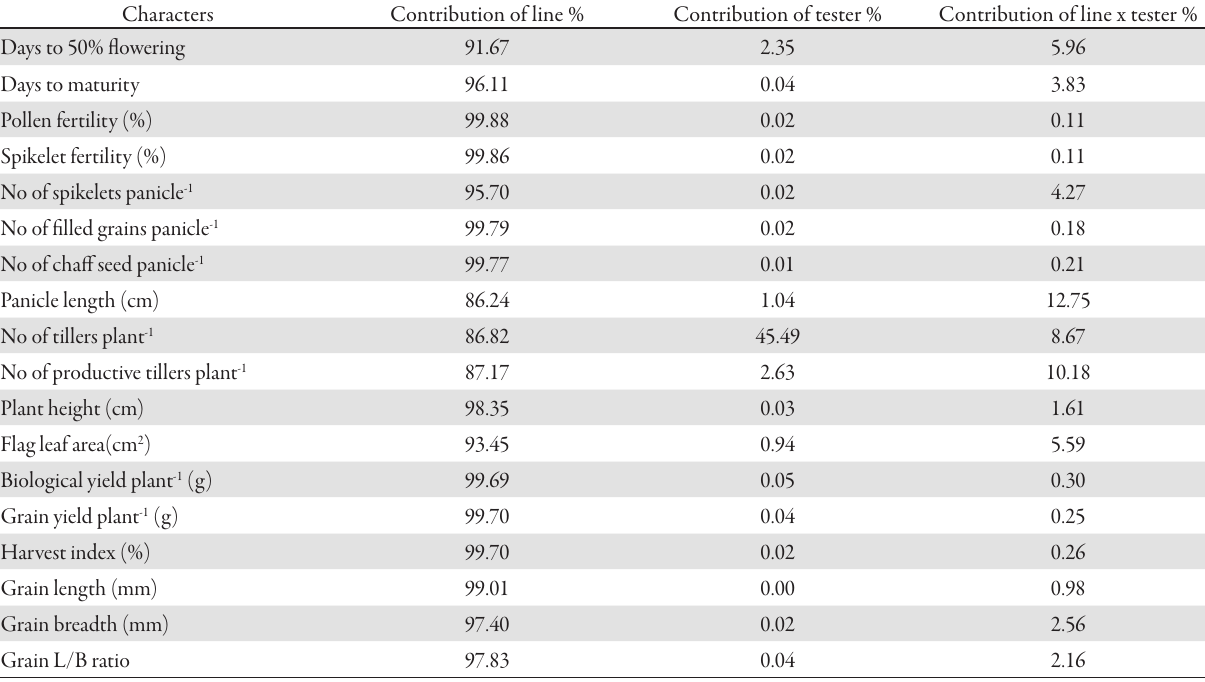
Tab. 3. Percent contribution of different components (lines, testers and lines x testers) towards the hybrid sum of squares for various agro-morphological traits in